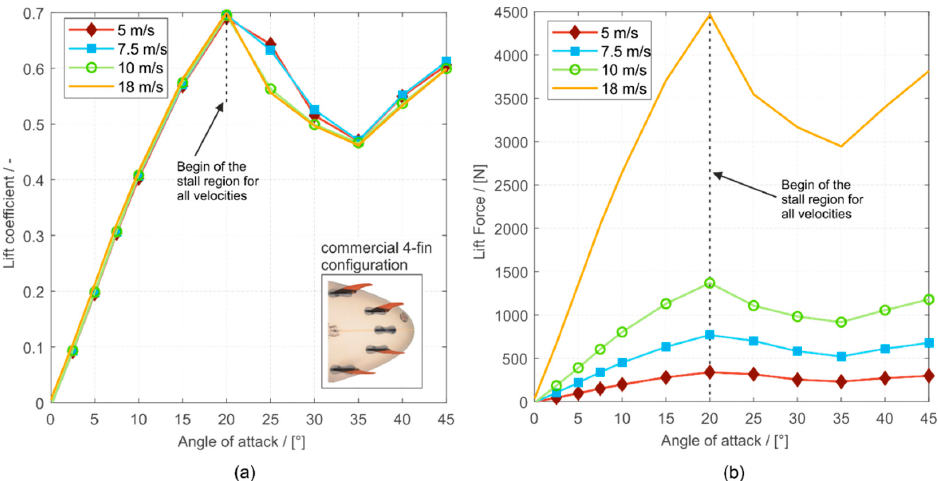
Figure 11. Governing velocity field and streamlines around the fins for ( a ) AoA = 15 ◦ , ( b ) AoA = 20 ◦ , and ( c ) AoA = 25 ◦ .